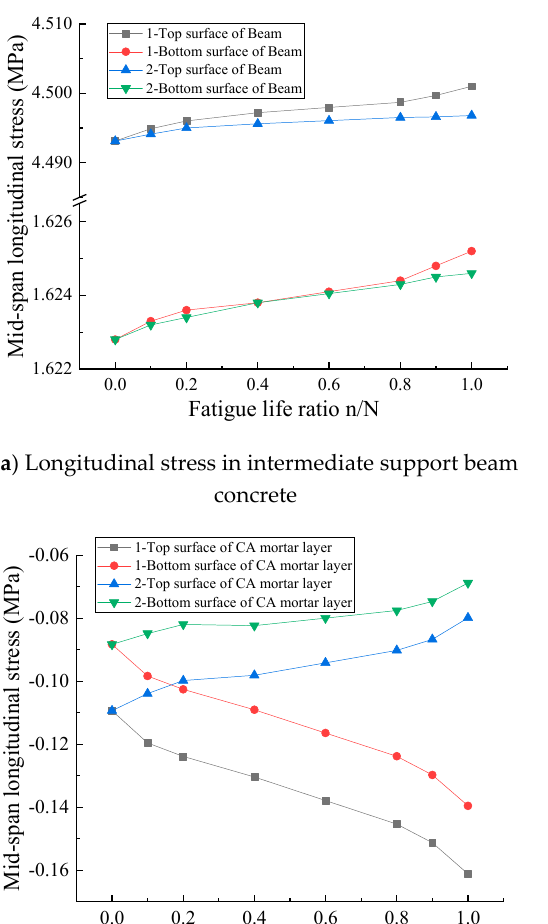
degradation. Note: 1: denotes the longitudinal stress regardless of CA mortar layer degradation; 2: